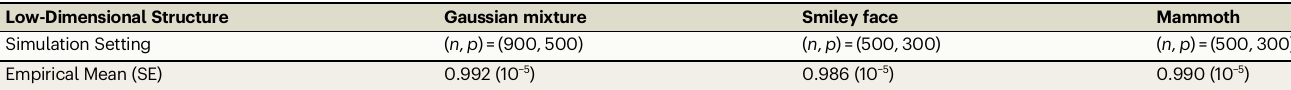
Table 1 | Empirical mean and standard error (SE) of the averaged cosines 1 true concordance measures, over each family of datasets associated with a given low-dimensional structure under various values of the SNR parameter θ